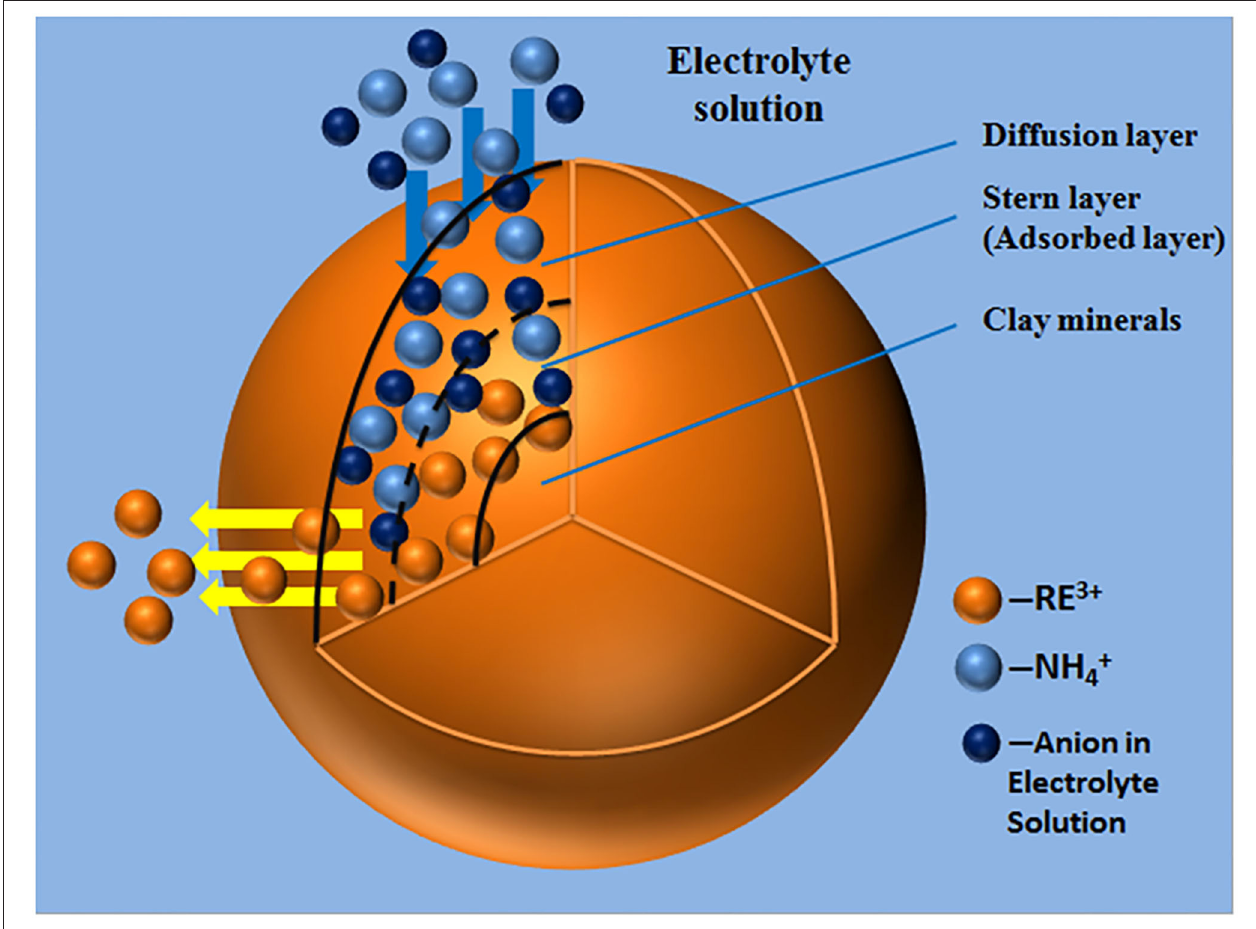
FIGURE 5 | Ion exchange